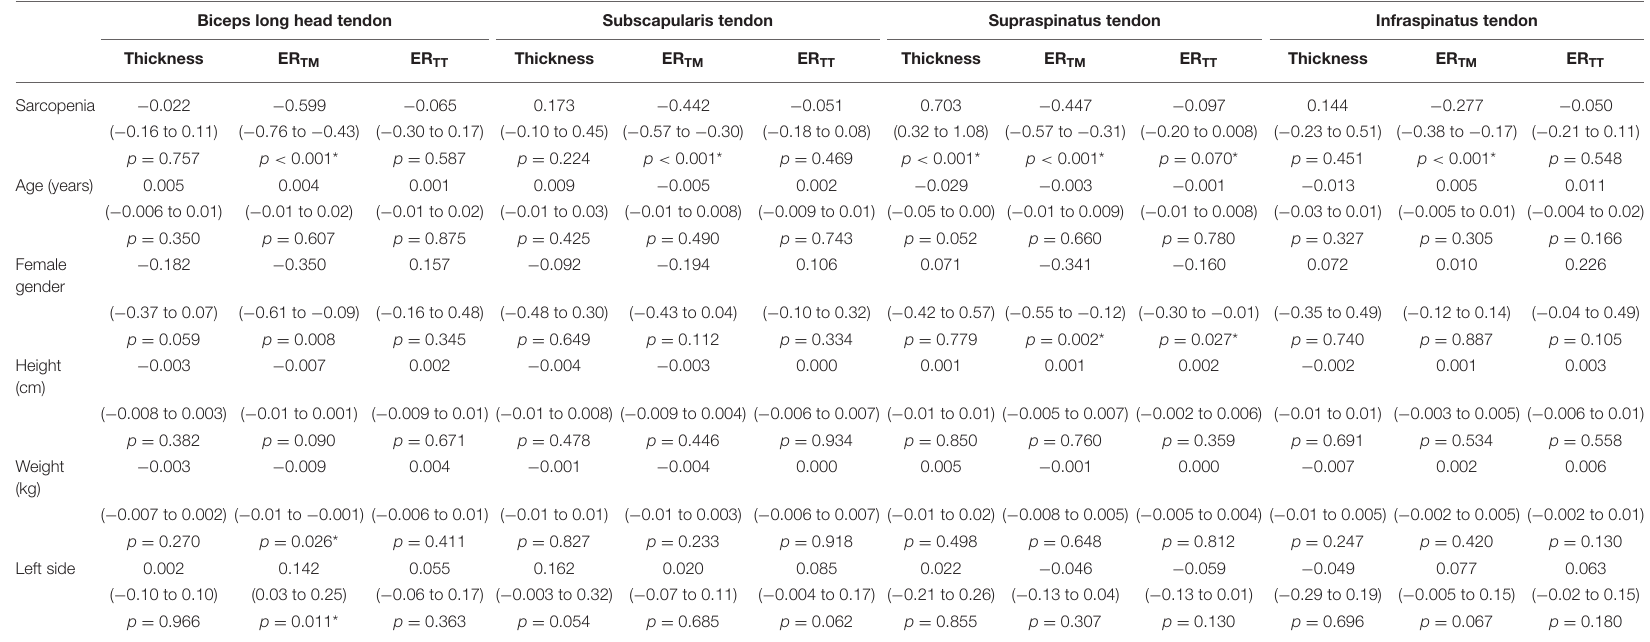
TABLE 3 | Association of sarcopenia and demographics with quantitative ultrasound measurements of rotator cuff tendon complex. Biceps long head tendon Subscapularis tendon Supraspinatus tendon Infraspinatus tendon